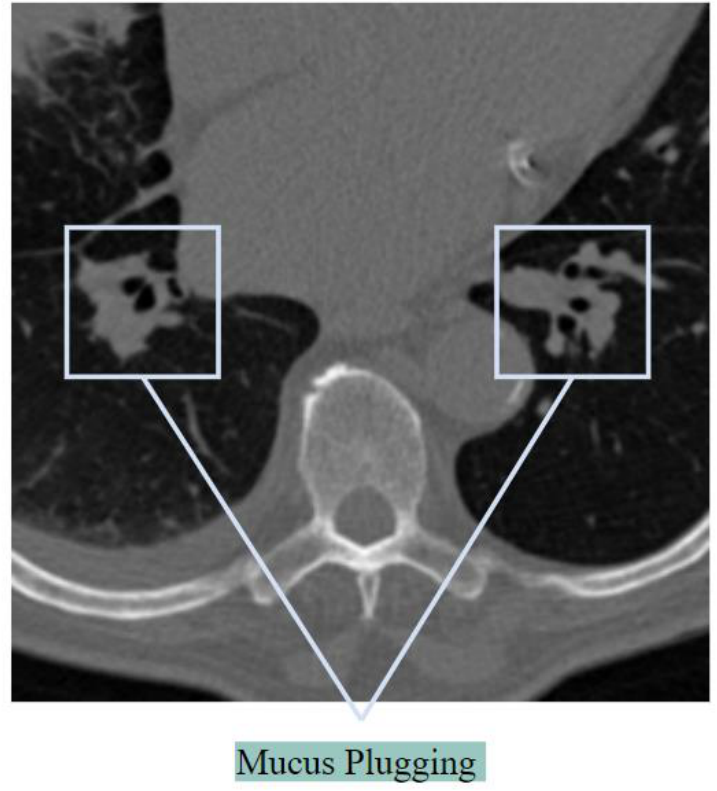
Figure 7. Mucus plugging as seen in a CT scan.